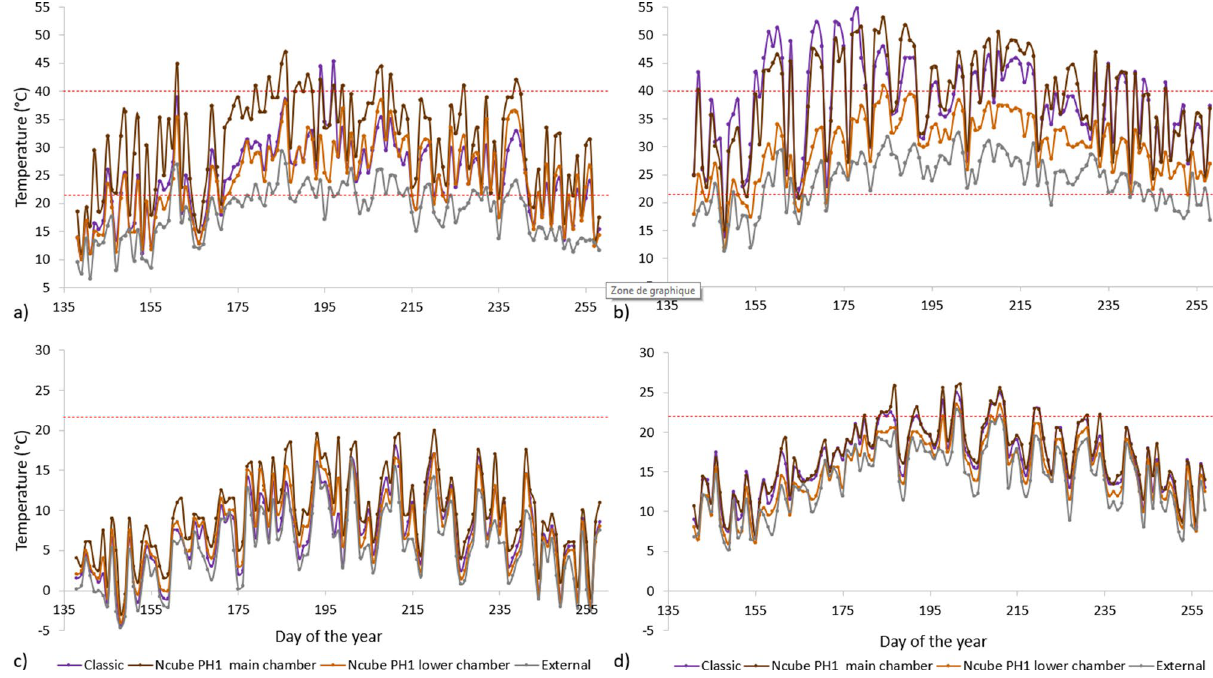
Figure 4. Daily minimum and maximum temperatures in the Classic and the Ncube PH1 bat boxes on buildings and the external temperature in 2019 at cooler and warmer sites, in Quebec. ( a ) daily maximum temperatures at the cooler site, ( b ) daily maximum temperatures at the warmer site, ( c ) daily minimum temperatures at the cooler site, ( d ) daily minimum temperatures at the warmer site. The red dotted lines represent the extended optimal temperature range of 22–40